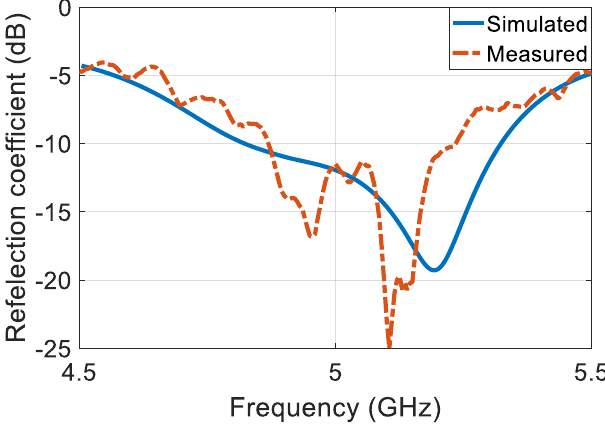
Figure 9: Reflection coefficient of the proposed